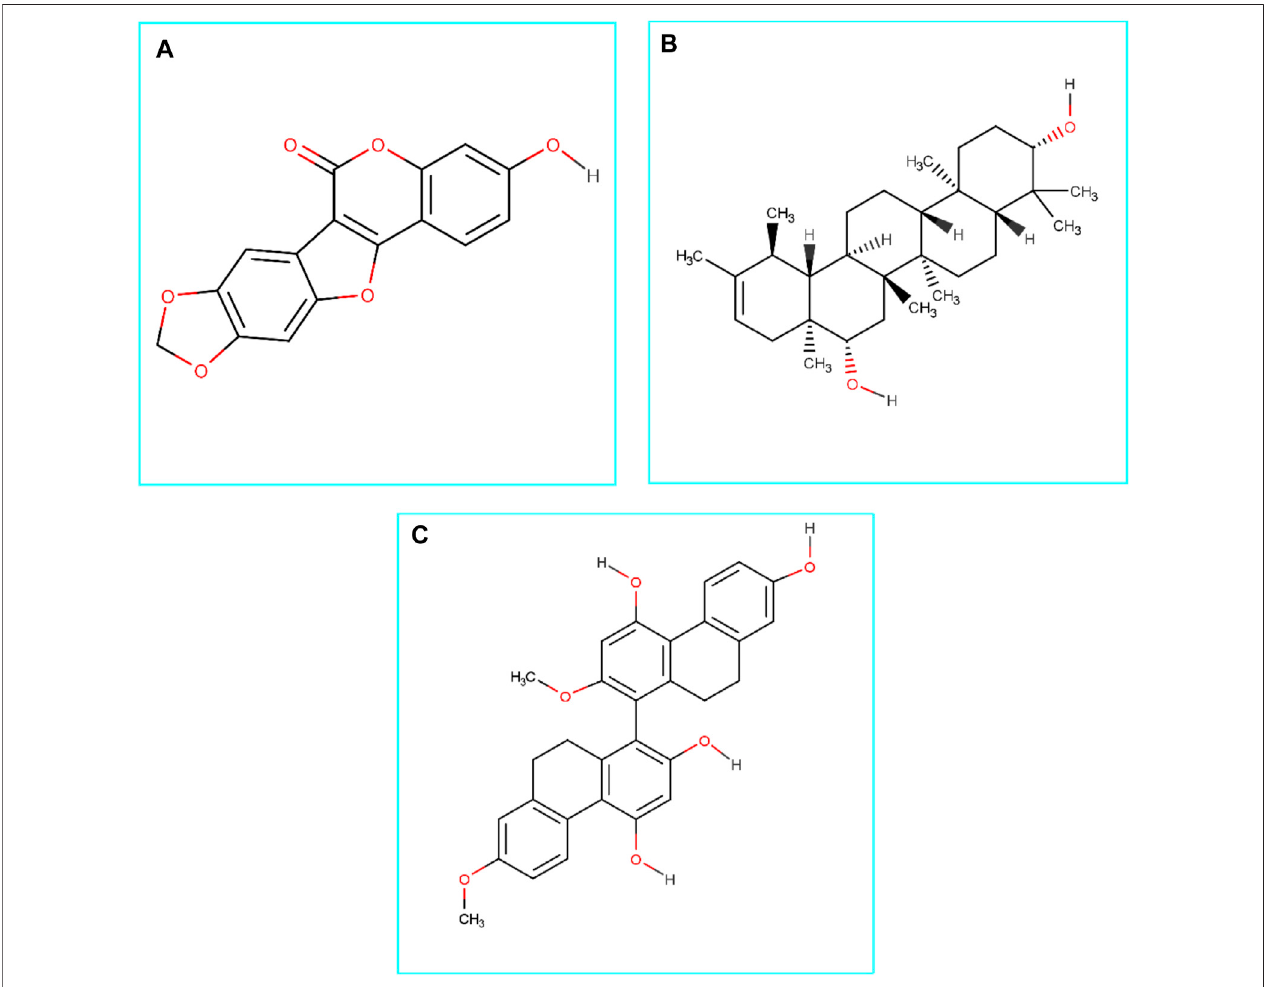
FIGURE 1 | Chemical structures (2D) of Medicagol (A) , Faradiol (B) , and Flavanthrin (C) . The structures were drawn using Marvin Sketch